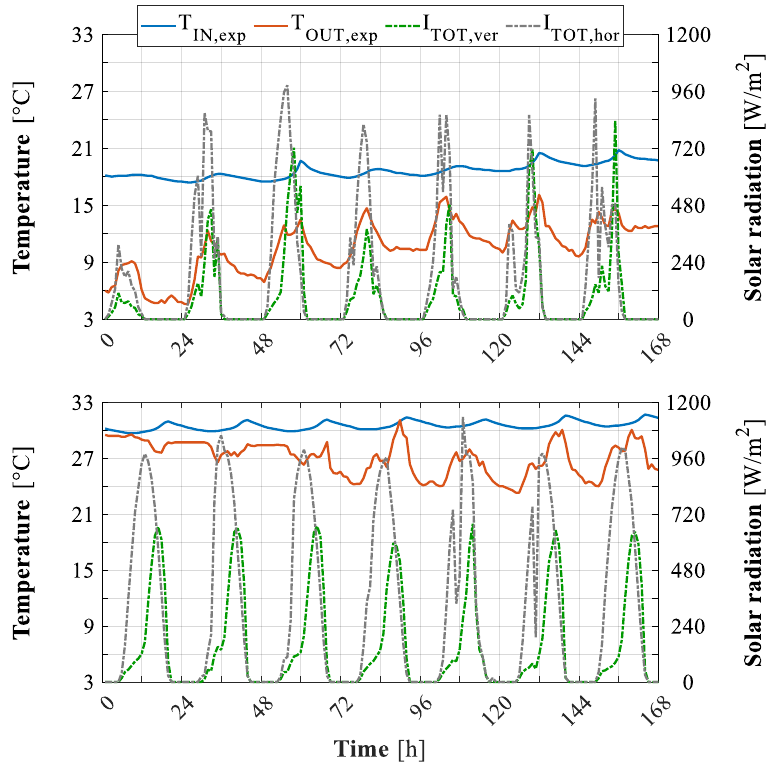
Figure 9. Time histories of indoor and outdoor air temperatures and solar radiations incident on the vertical South-West façade and on the horizontal roof—Sample winter week: March 23rd–29th ( top ) and sample summer one: July 1st–7th ( bottom ).